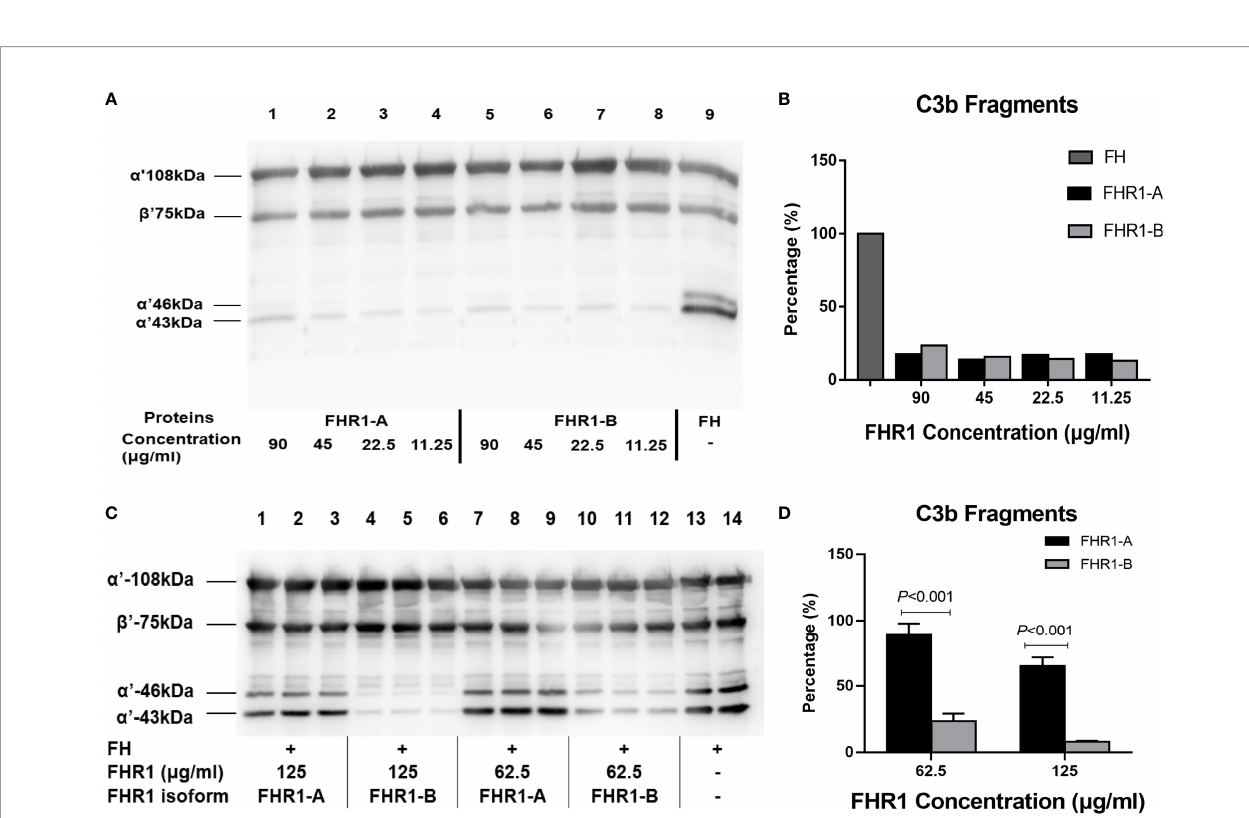
FIGURE 5 | Effect of the FHR1 isoforms on the cofactor activity of FH. Compared to FH (positive control, lane 9), both FHR1*A (lanes 1-3) and FHR1*B (lanes 4-6) at concentrations of 90-11.25 ug/ml showed no or little FI cofactor activity (A) . When incubated with C3b, FI and FH together, the FHR1 groups (lanes 1-3, 4-6, 7-9, 10-12 were technical replicates, respectively; (C) generated fewer C3b cleavage products than the group without FHR1 (no-FHR1 control, lanes 13-14, technical replicates; (C) . Furthermore, the FHR1*B groups generated more C3b cleavage products than the FHR1*A groups at the same concentrations (C, D) . The data are presented as the means ± SDs.